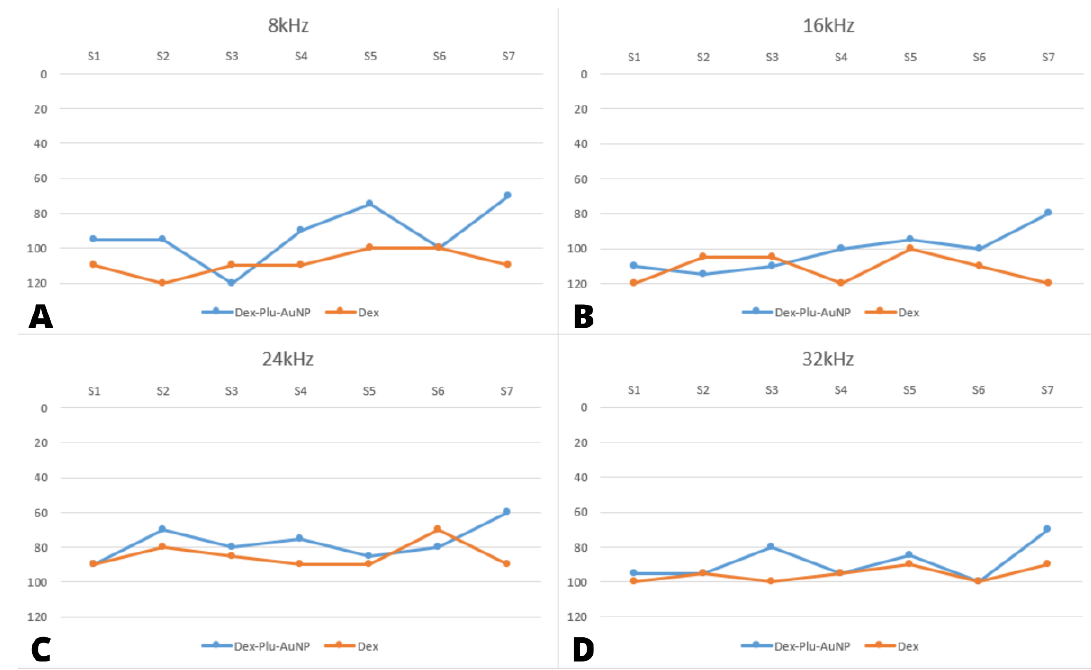
Figure 3. Representation of postoperative hearing threshold for rats in both groups, measured